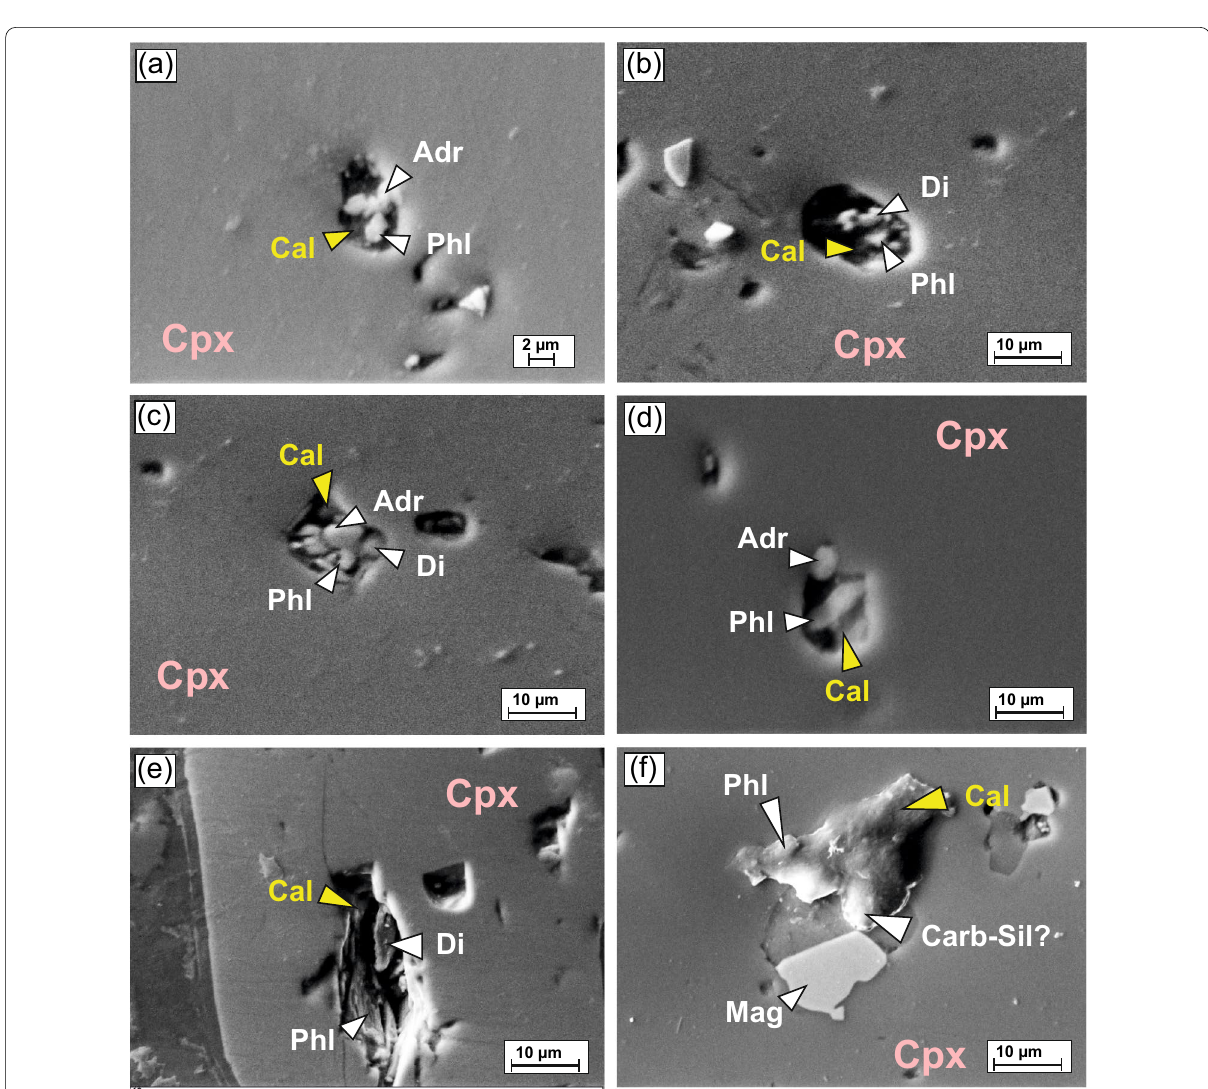
Fig. 6 BSE images of the exposed carbonate–silicate melt inclusions in clinopyroxene from Sung Valley ijolites. BSE images showing the presence of alkali-bearing diopside, phlogopite, andradite, magnetite, and carbonated silicate daughter crystals with calcite. Di Diopside, Phl Phlogopite, Adr Andradite, Mag